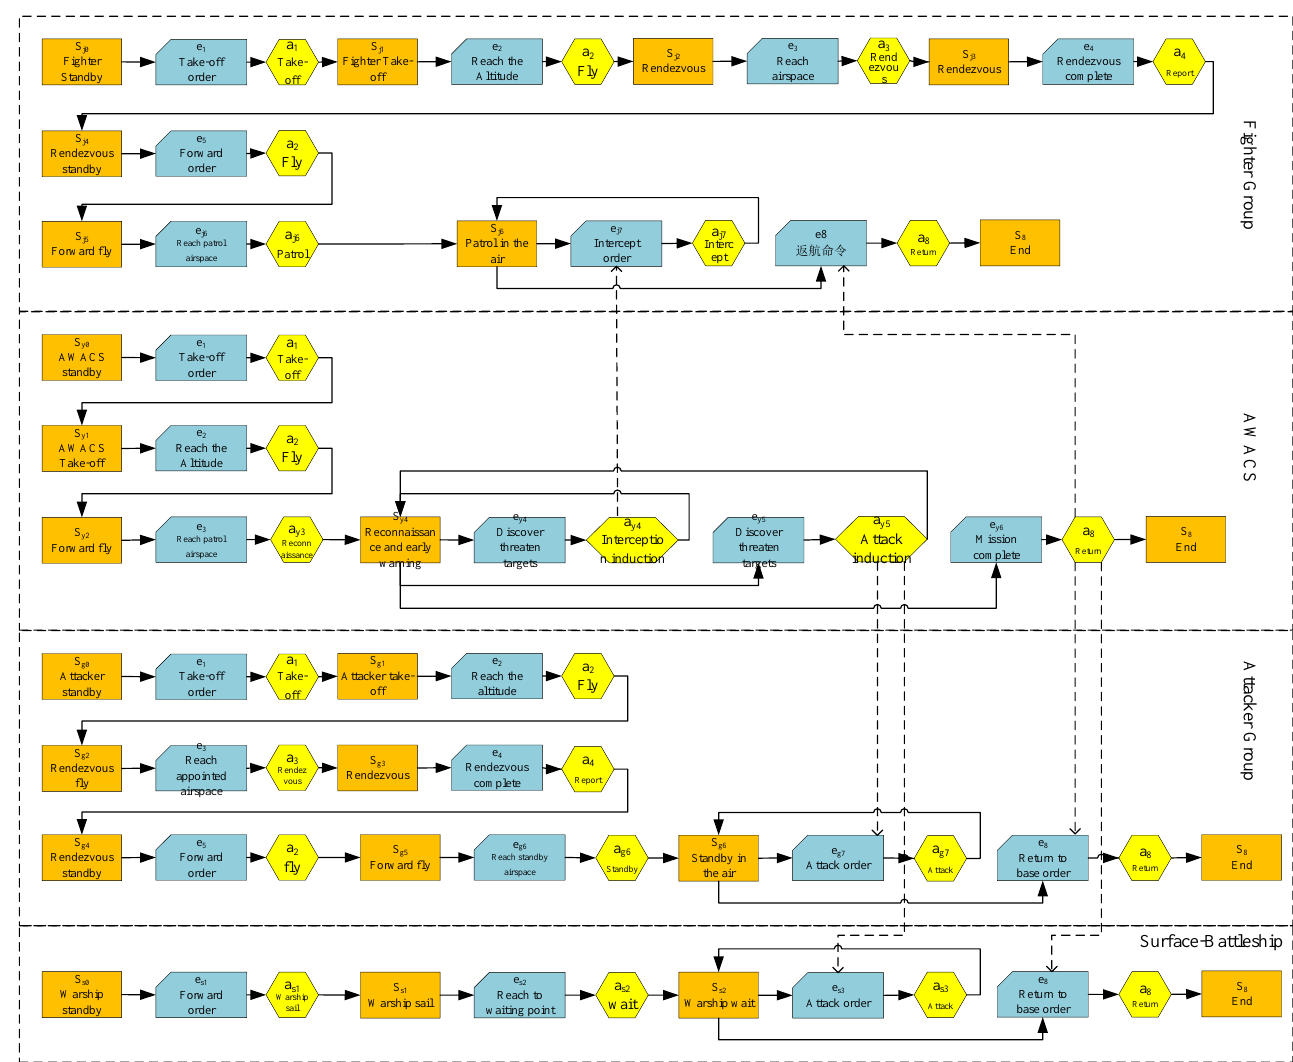
Figure 5. Analysis of air – sea jointed anti-sea assault scenarios. (3) Trigger event analysis.